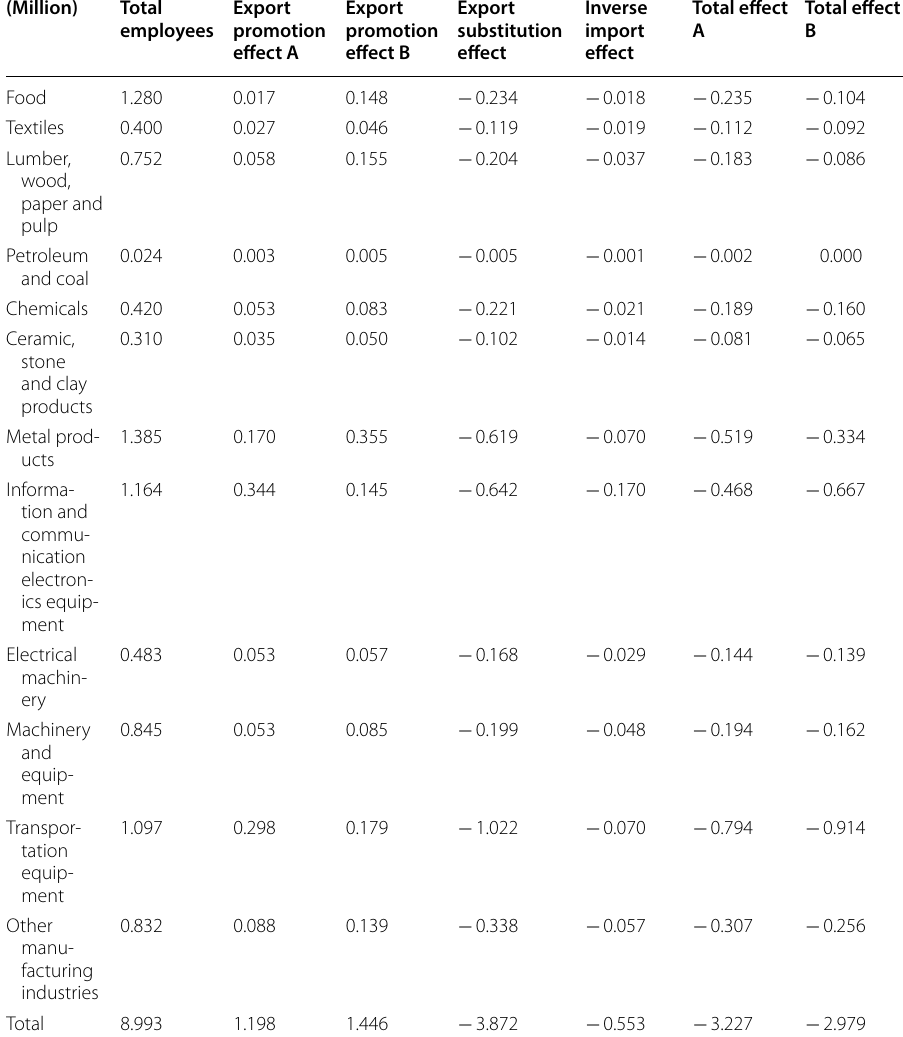
Table 2 Impact on the employment of Japan’s manufacturing industry in